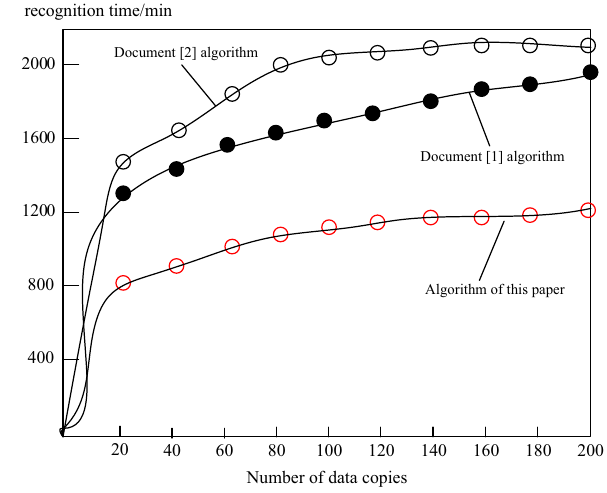
Figure 7: Image edge details enhanced recognition e ffi ciency